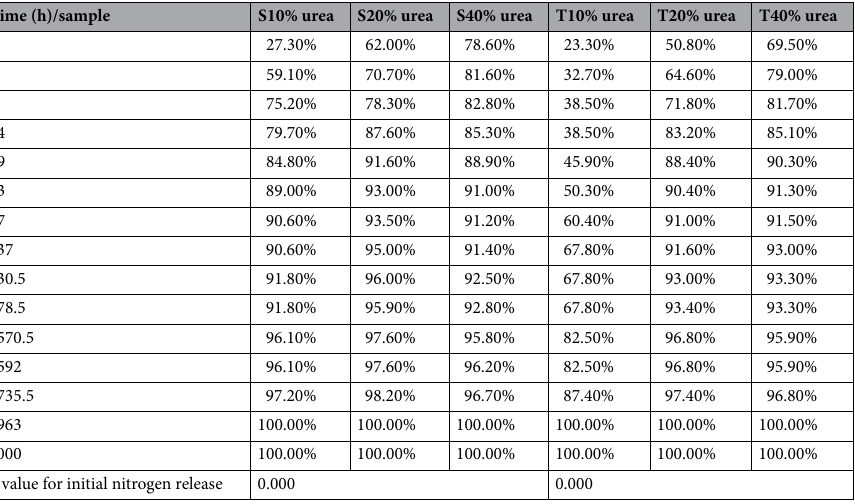
Table 2. Nitrogen release rate from single- and triple-layer nanofibre structures from first hour till 3000 h. S single-layered PLLA nanofibre mat, T triple-layered PHB/PLLA/PHB nanofibrous structure, P value probability